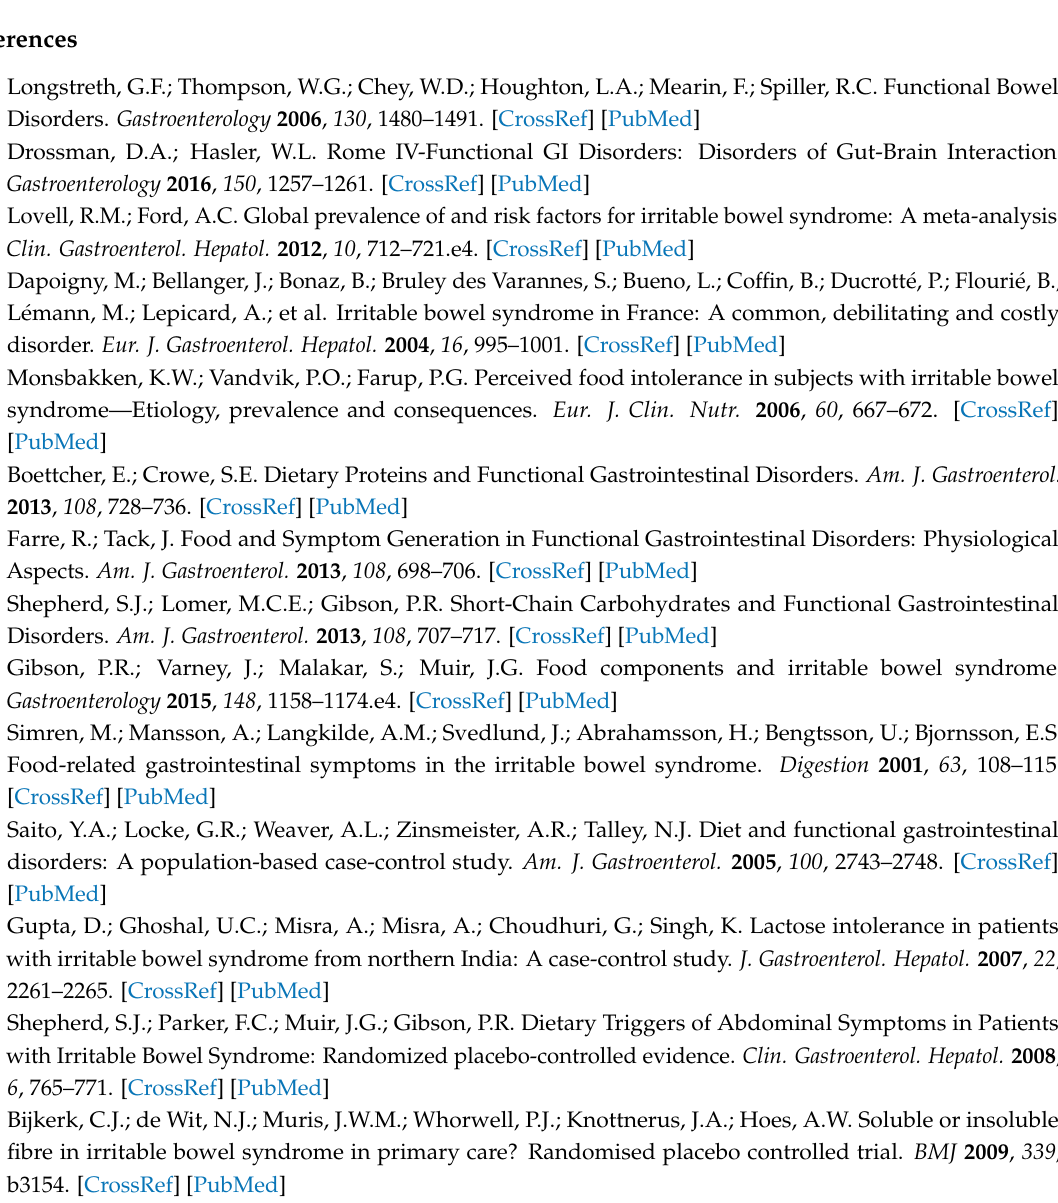
IBS cases ( n = 39,298), Table S3: Comparison of daily intake of macronutrients between quintiles (Q) of western pattern ( n = 44,350), Table S4: Comparison of daily intake of micronutrients between quintiles (Q) of western pattern ( n =